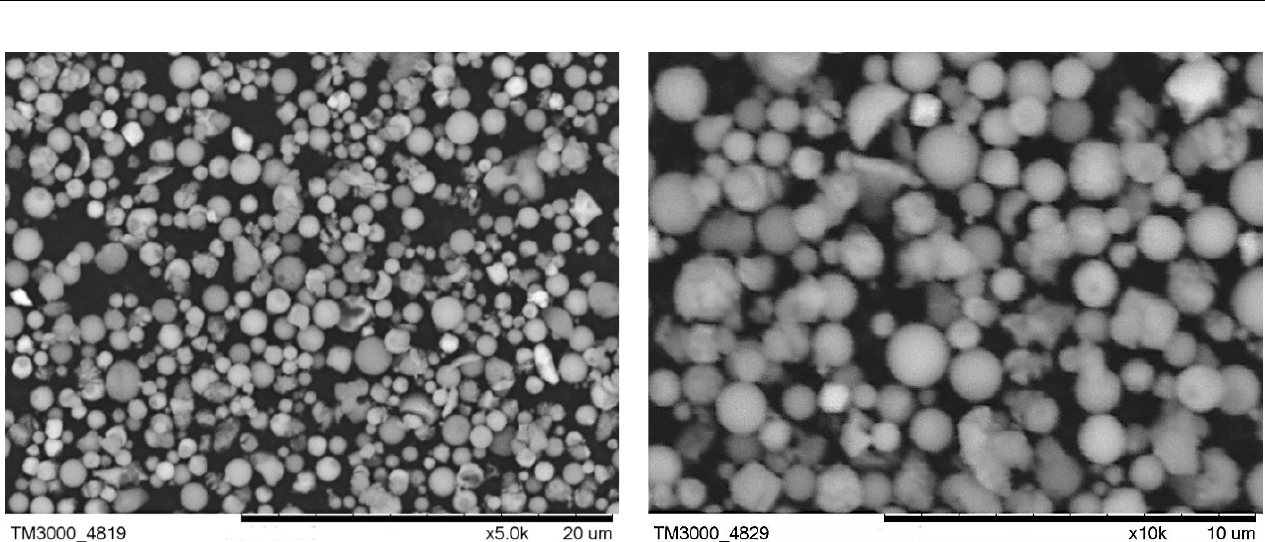
Figure 2. SEM images of the fine narrow fraction.